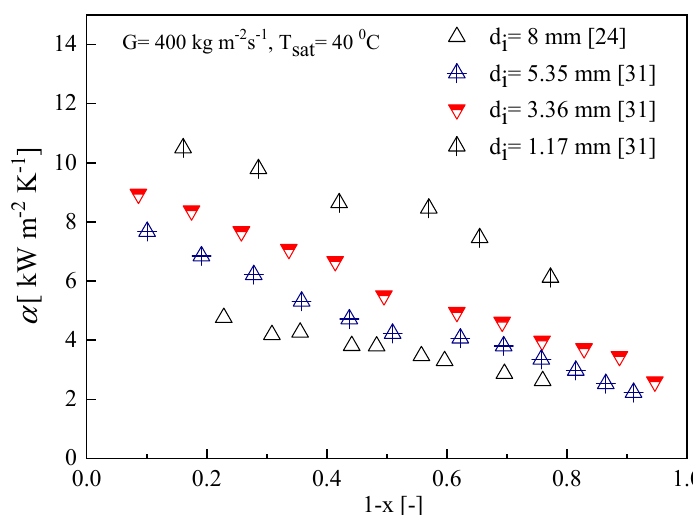
Figure 14. Average condensation heat transfer coefficient of different tube, inner diameter of 8 mm [24], 5.35 mm [31], 3.36 mm [31] and 1.17 mm [31] at mass flux 400 kg m − 2 s − 1 .